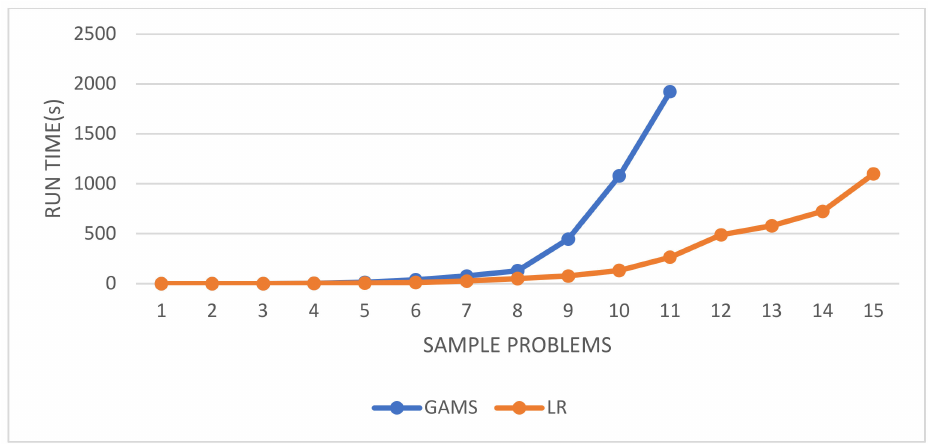
Figure 6. Run time of sample problems with and without “LR”